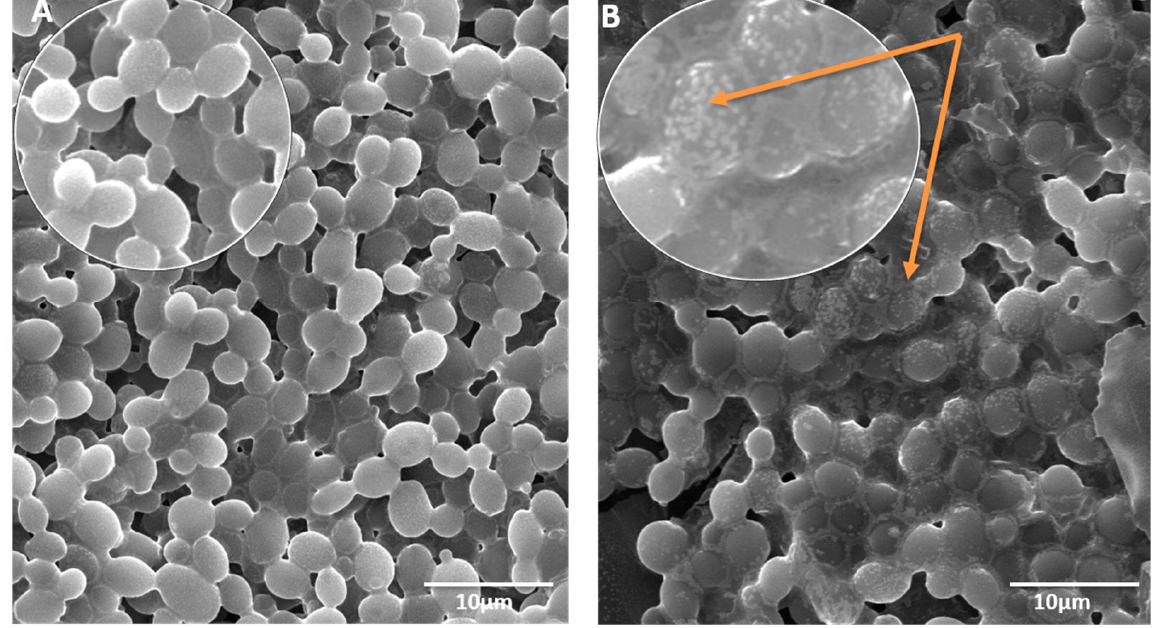
Figure 7. SEM micrograph presenting the morphogenesis of C. albicans. ( A ) Untreated cells (control); ( B ) MCs Treated cells.